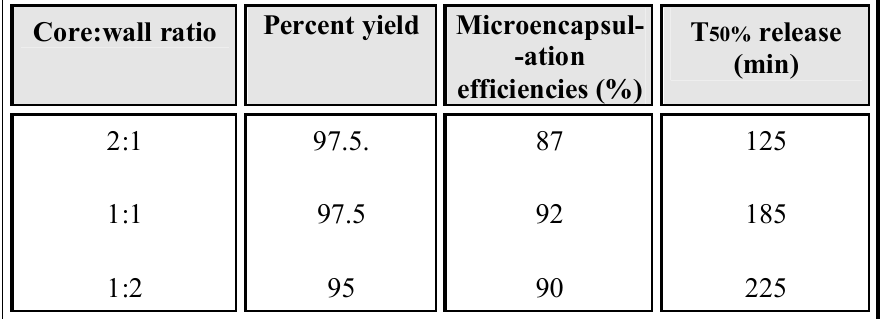
Table(2)Effect of Varying Core:Wall Ratio on Ibuprofen Microcapsules Prepared by a Modified Organic Method